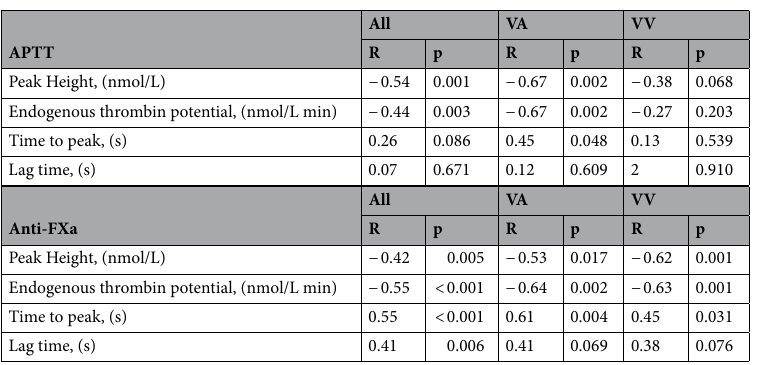
Circuit variables. ECMO circuit and cannulation details are outlined in Table S8 and S9. VV patients had higher transmembrane pressure gradients compared to VA patients.